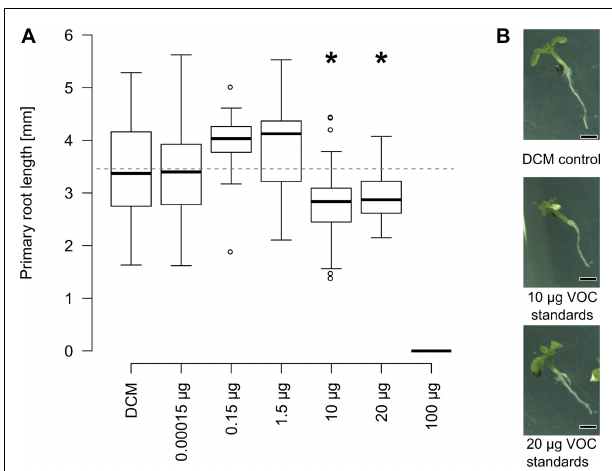
FIGURE 6 | Effect of VOC standards identified in soil on root growth. (A) Arabidopsis plants were grown on tripartite plates, as described in Figure 1 . Instead of soil, the second compartment harbored cotton with mixtures of 2-ethyl-1-hexanol, furfural, 5-methyl-2-furancarboxaldehyde, nonanal, decanal, 5-methyl-3-heptanone and benzaldehyde in dichloromethane. Primary root length was mostly unaffected by low concentration, significantly smaller between 10 and 20 µ g than plants exposed to dichloromethane without additional VOCs. Germination was fully suppressed at 100 µ g ( ∗ p ≤ 0.05, Kruskal Wallis, n = 15–45 seedlings pooled from 6 to 15 Petri dishes). (B) Speciemen of 11-days old Arabidopsis plants exposed to different volatile blends at the end of the experiment (scale bar = 1